Question: What visual encoding does this figure use to show its data?
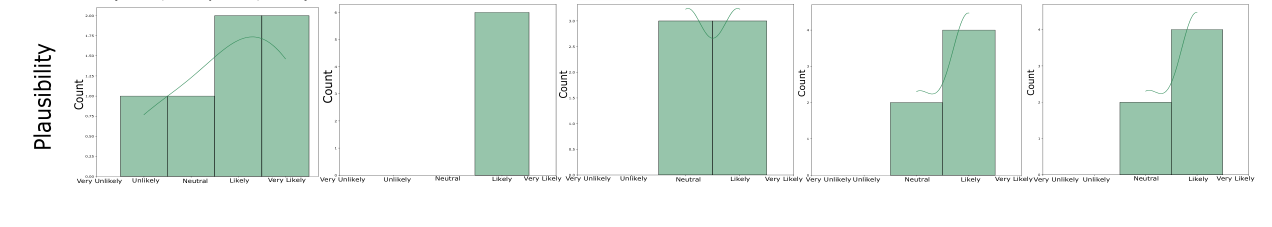
Answer: histogram